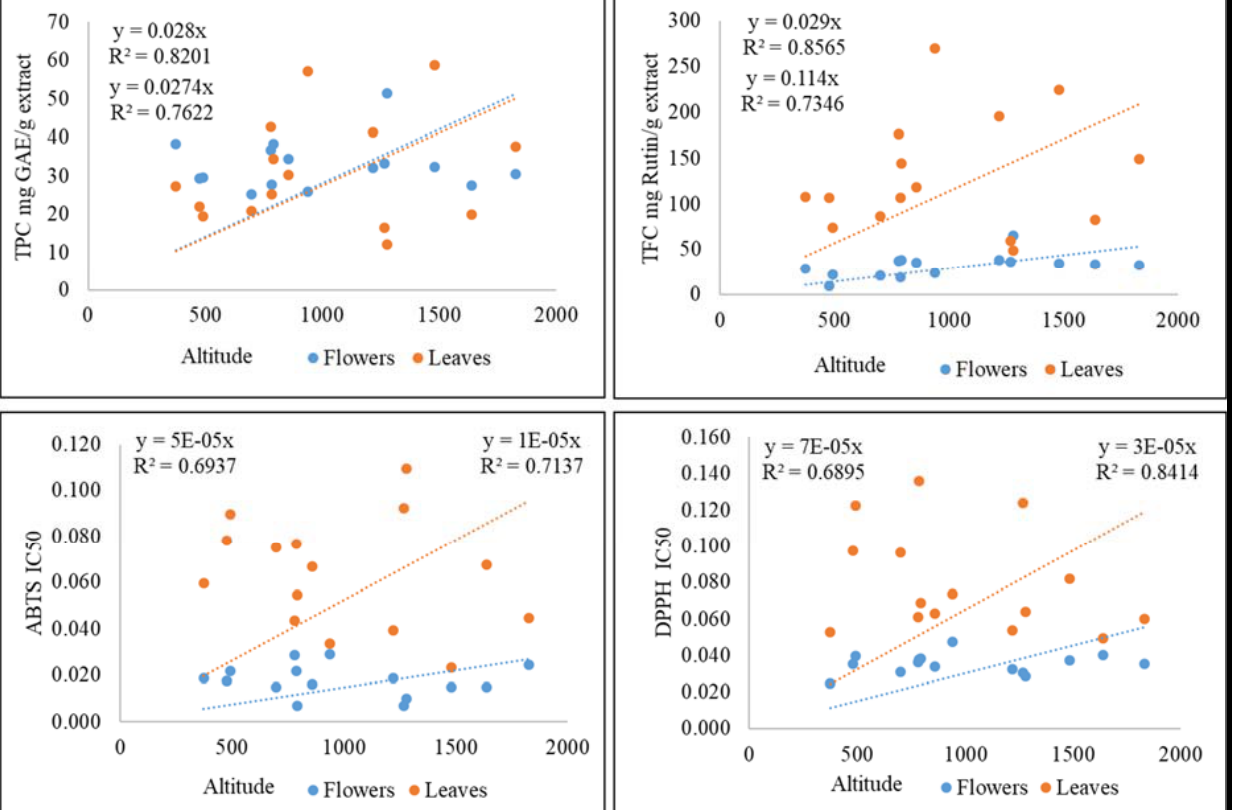
Figure 5. Correlation of TPC, TFC, ABTS, and DPPH with altitudes.